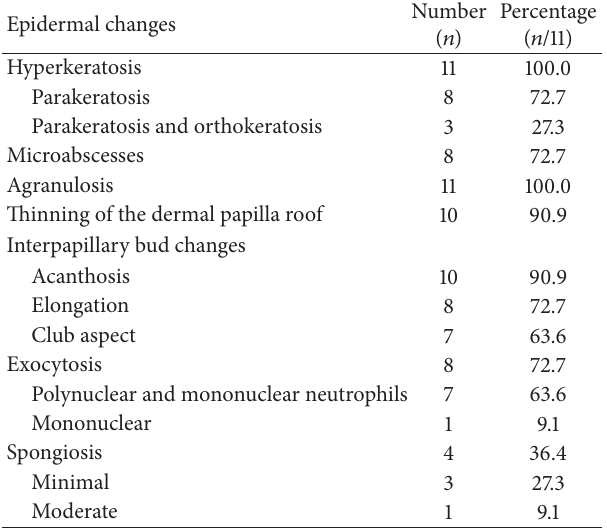
Table 1: Histological epidermal changes in 11 severe psoriasis cases.